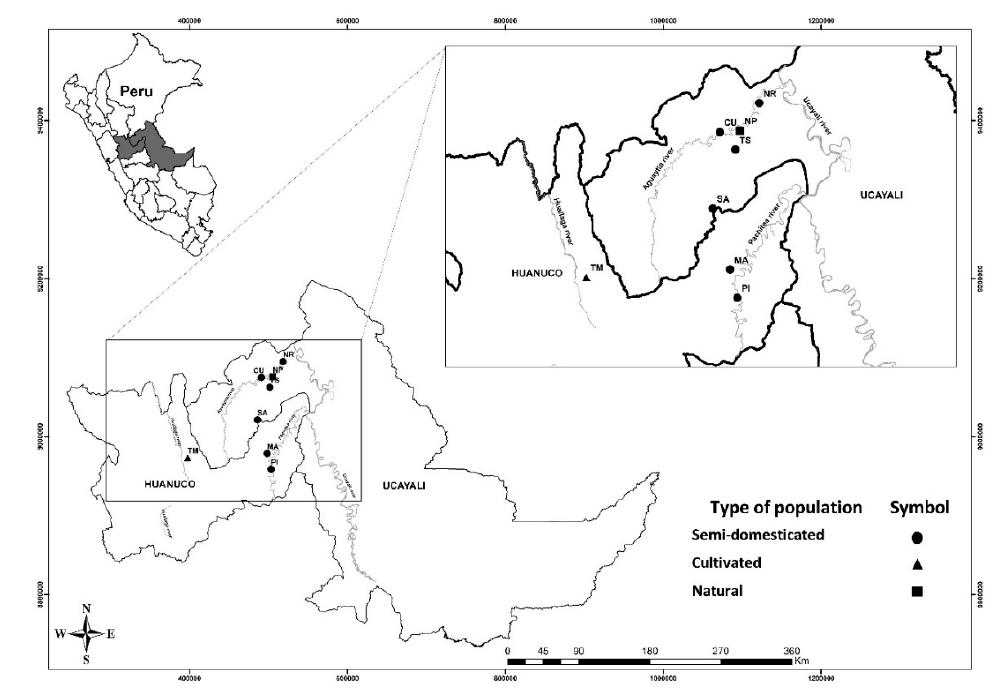
Figure 1. Map of the geographic distribution of eight Guazuma crinita provenances sampled in Peru. NP = Nuevo Piura—naturally regenerated population. TM = Tingo Maria—cultivated population. NR = Nueva Requena, SA = San Alejandro, PI = Puerto Inca, CU = Curimana, MA = Macuya and TS = Tahuayo—semi-domesticated populations.